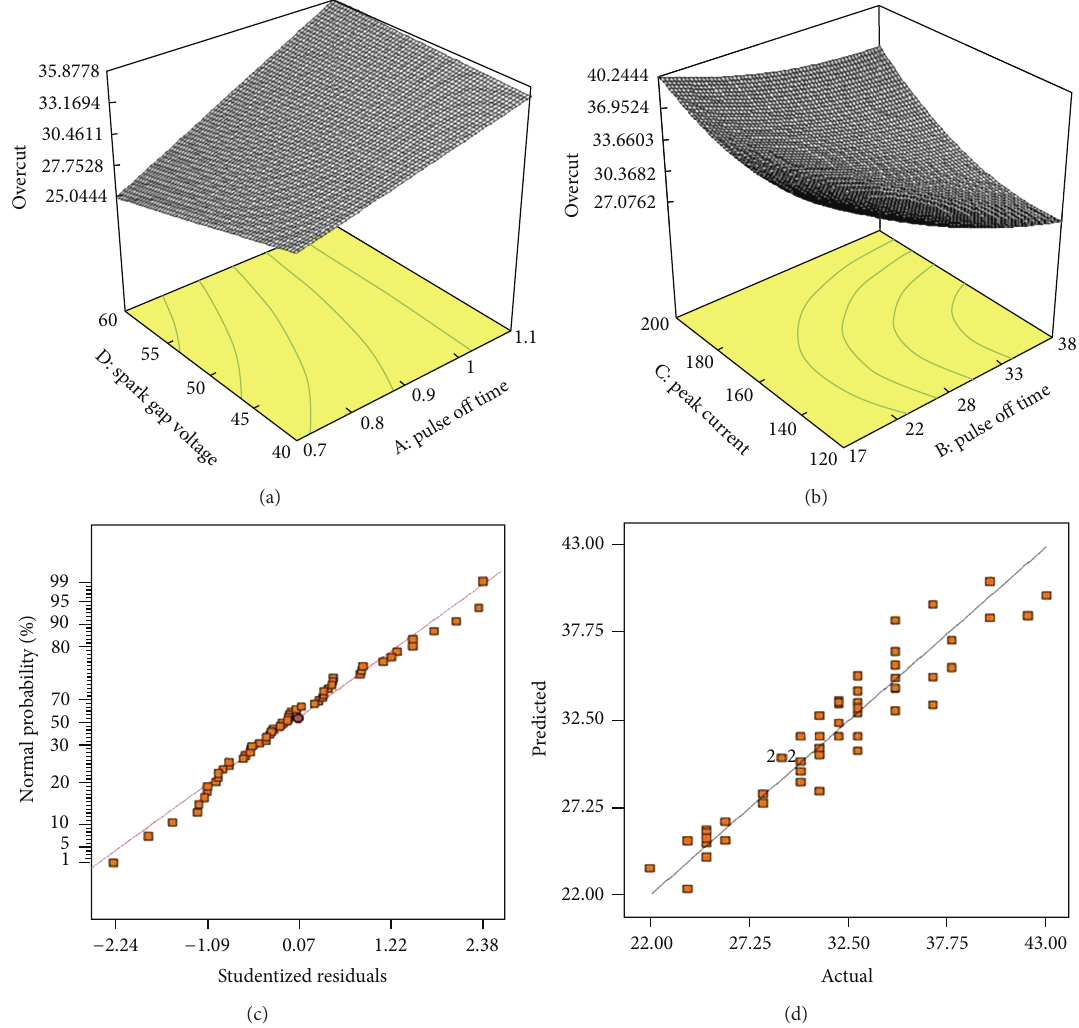
Figure 3: Response surface plot for overcut: (a) interaction plot between pulse on time and spark gap votage, (b) interaction plot between pulse off time and peak current, (c) normal probability plot residuals, (d) actual versus predicted values.